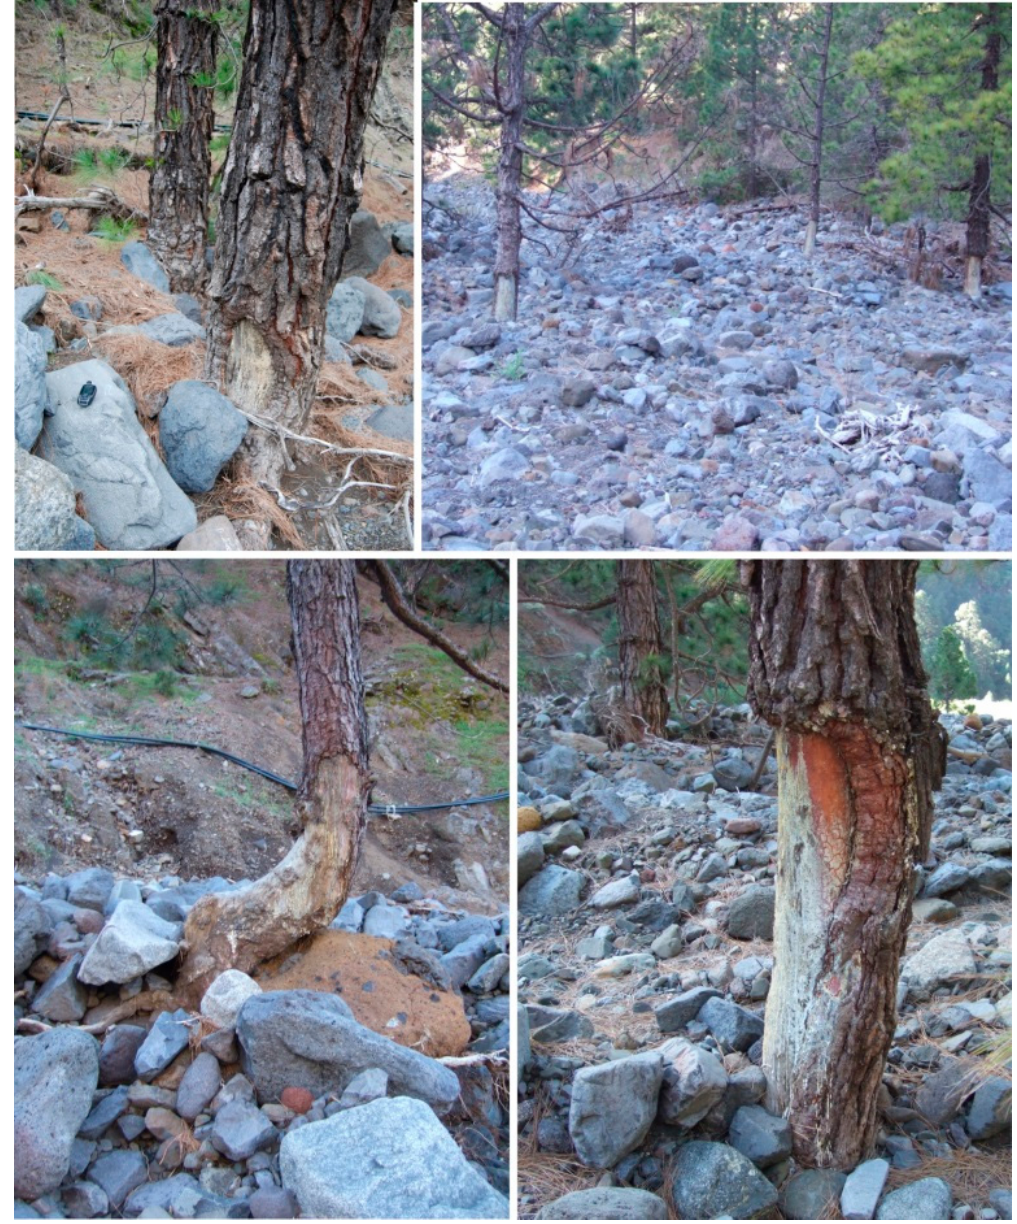
Figure 2. Mosaic images of some of the damaged trees during the 1997 flash-flood event in “Playa de Taburiente”.